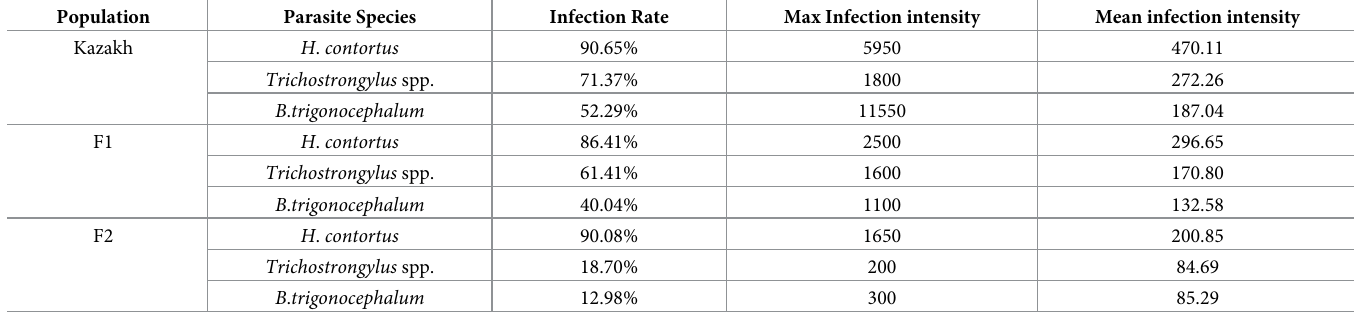
Table 8. Dominant species of sheep GINs in